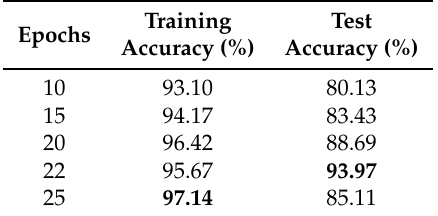
Table 7. Training and test accuracy achieved with AdaBoost-optimised custom CNN.